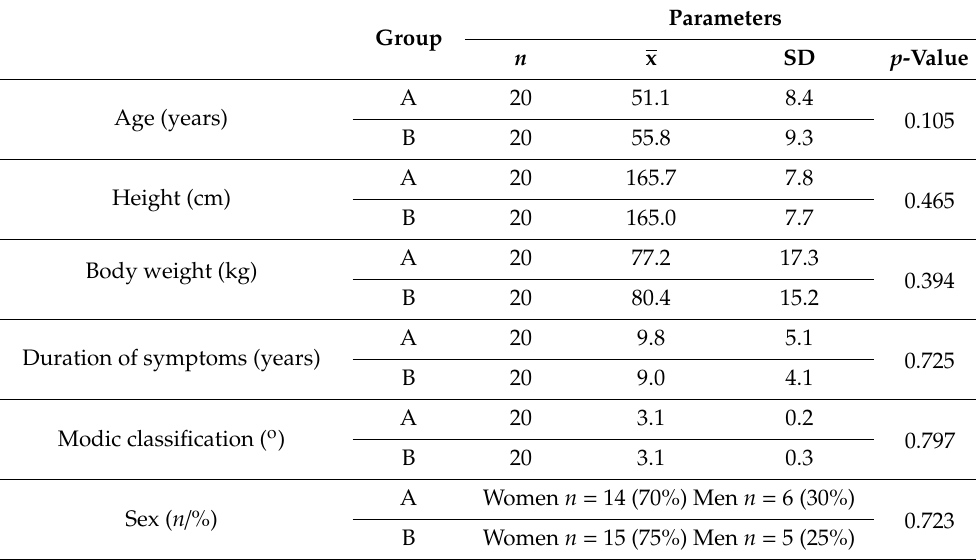
Table 1. Characteristics of the participants included in the